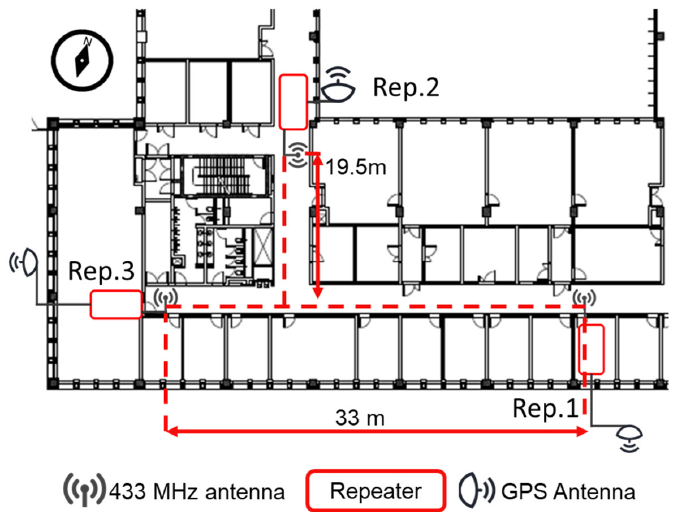
Figure 8. The location of repeaters on the floor plan of Sabancı University Faculty of Engineering and Natural Sciences (FENS) Building 2nd Floor.